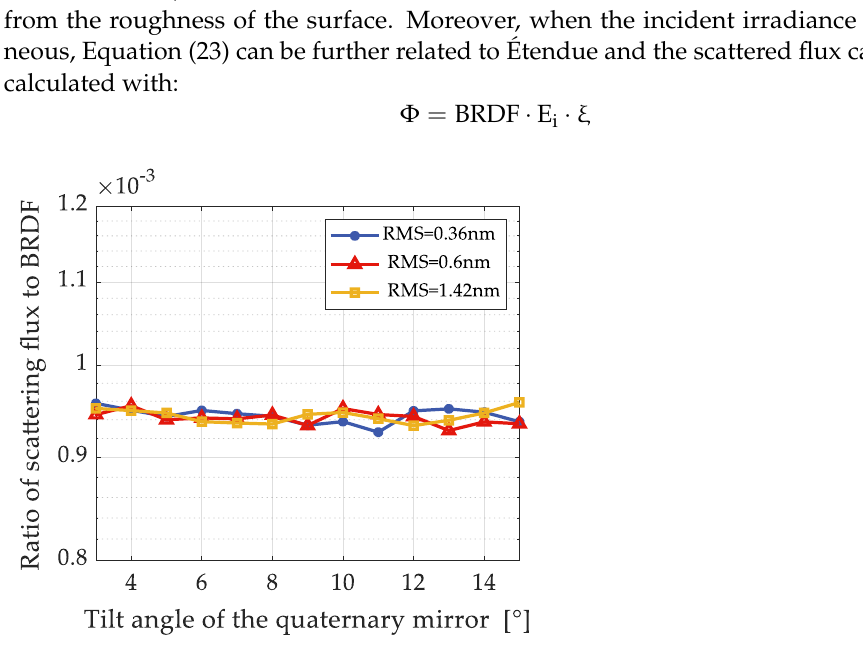
Figure 9. The ratio of backscattering flux to BRDF with respect to the tilt angle for the samples under different roughness.